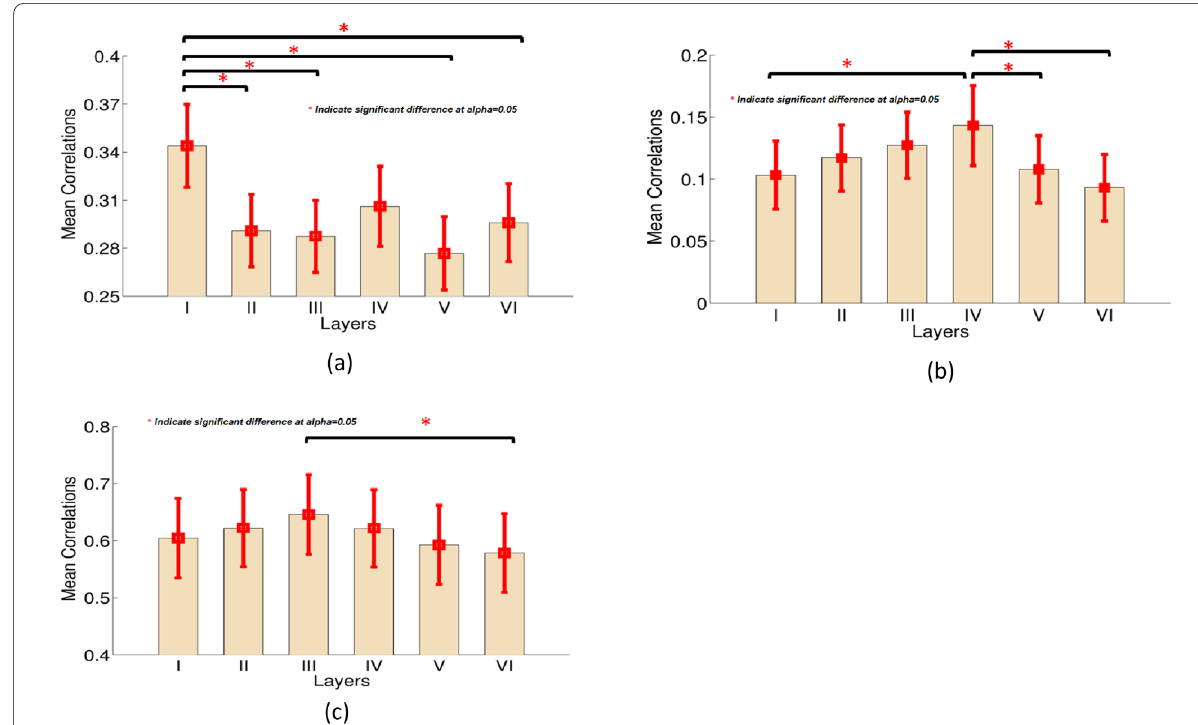
Fig. 4 a Mean thalamo-cortical FC values between the entire thalamus and all cortical layers estimated from BOLD data before blind deconvolution; b mean FC between the somatosensory thalamus (VPL) and six different layers of primary somatosensory cortex before blind deconvolution; c mean inter-hemispheric cortico-cortical laminar FC values estimated before blind deconvolution. *Significant difference with p (corrected) < 0.05, the error bar indicates the estimated standard